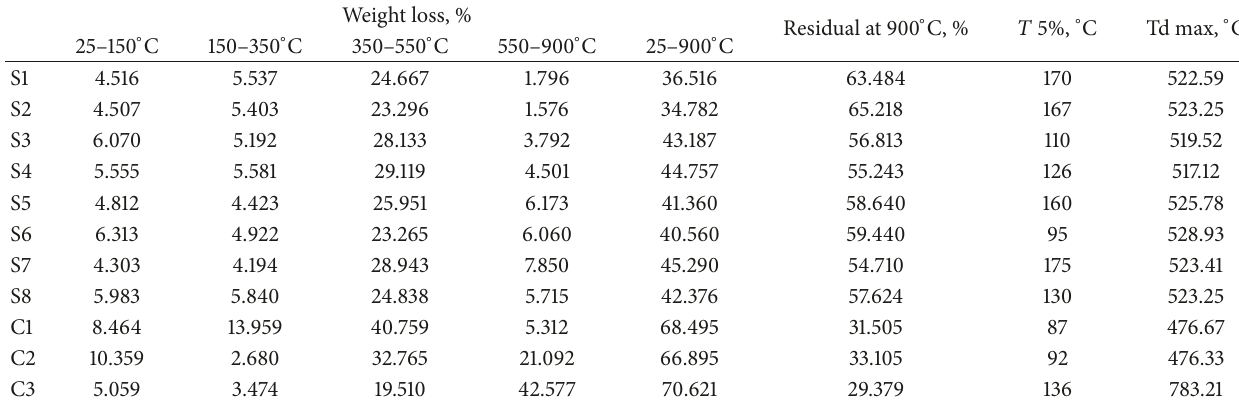
Table 2: Weight loss of all compounds at different temperature